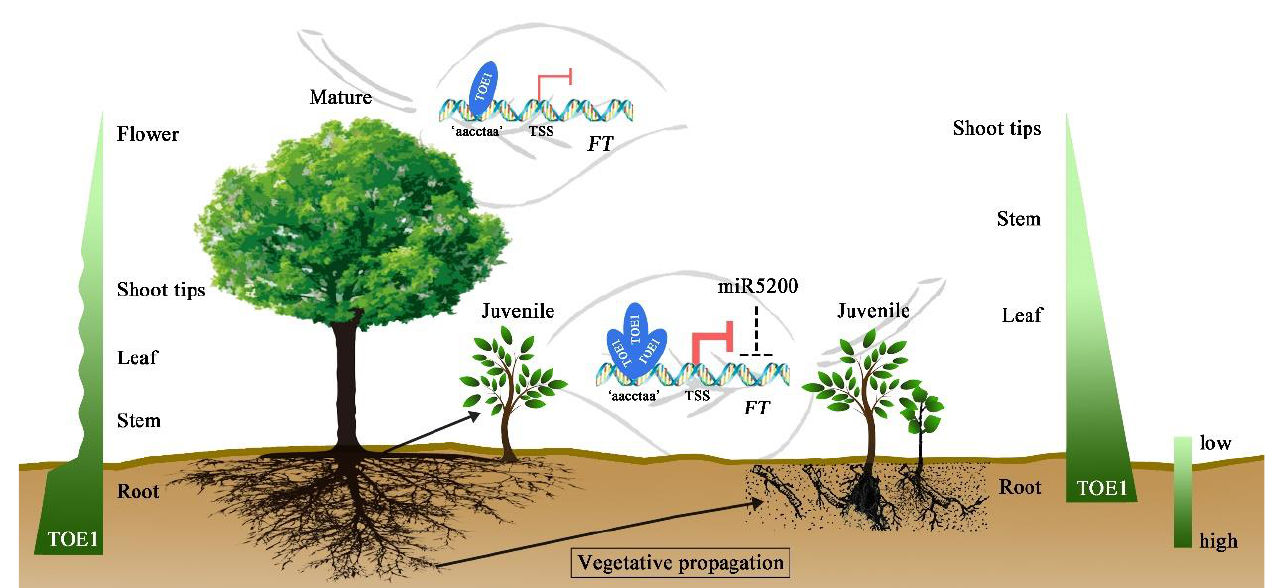
Figure 6. A proposed model illustrating the rejuvenation regulation of RpTOE1 and its expression patterns in R. pseudoacacia root-based vegetative propagation. RpTOE1 was expressed at a high level in the roots of mature trees and at a low level in the aboveground organs. The expression decreased gradually in the leaves, stems, and shoot tips of juvenile seedlings but fluctuated in these organs in mature trees, and the expression level was lowest in flowers. In the leaves of asexually propagated seedlings, the abundance of RpTOE1 increased, leading to enhanced inhibition of RpFT expression. RpTOE1 binds to the ‘aacctaa’ sequence of the RpFT promoter. The thin red arrowed line denotes low-level inhibition, and the thick red arrowed line denotes high-level inhibition. The flowers in the mature trees indicate reproductive ability.